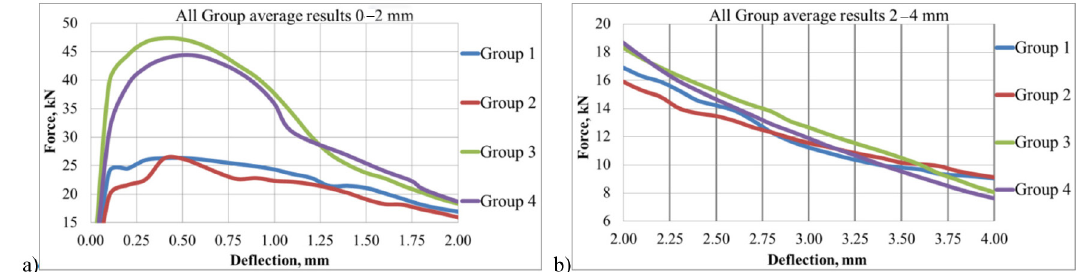
Fig. 6. Comparison of the average deflection results in all Groups 0–2 mm (a) and 2–4 mm